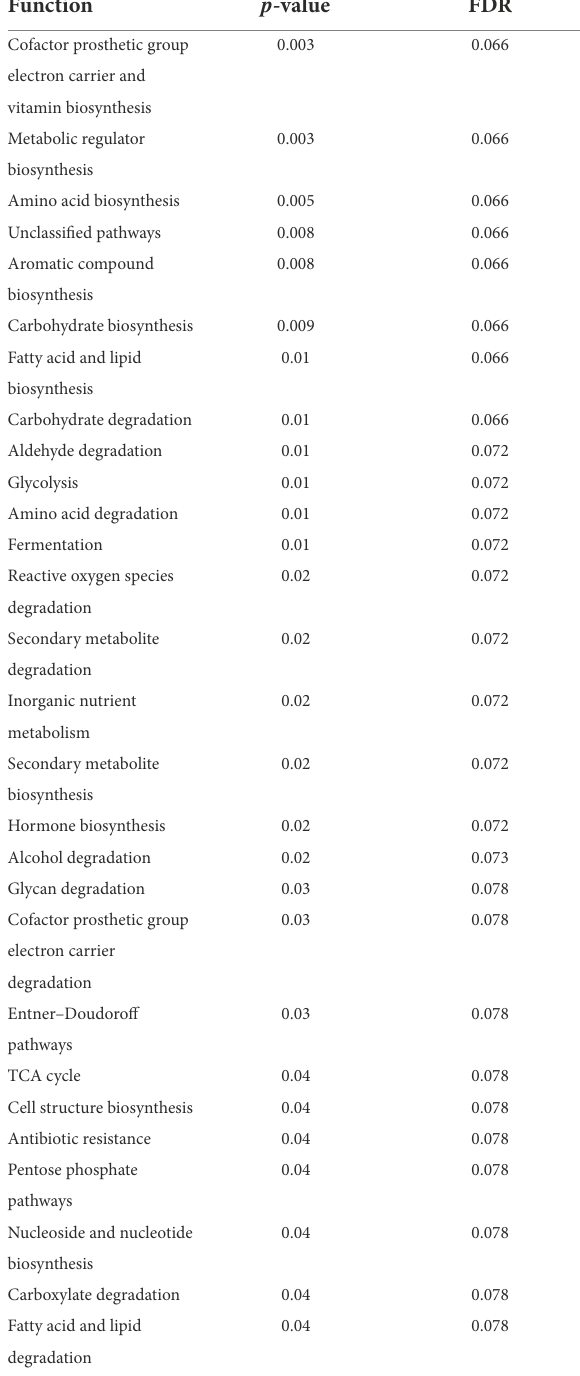
TABLE 4 Significantly different bacterial metabolic pathways identified in infant stool samples pre- and post-diet intervention (calculated using paired t -